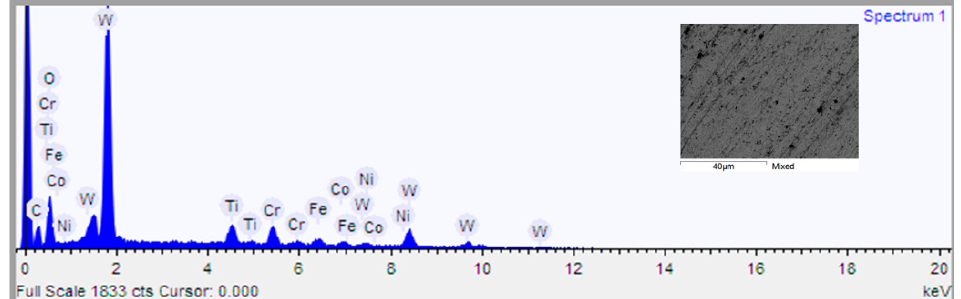
Figure 4. EDaX spectrum of tungsten carbide (WC) substrate.